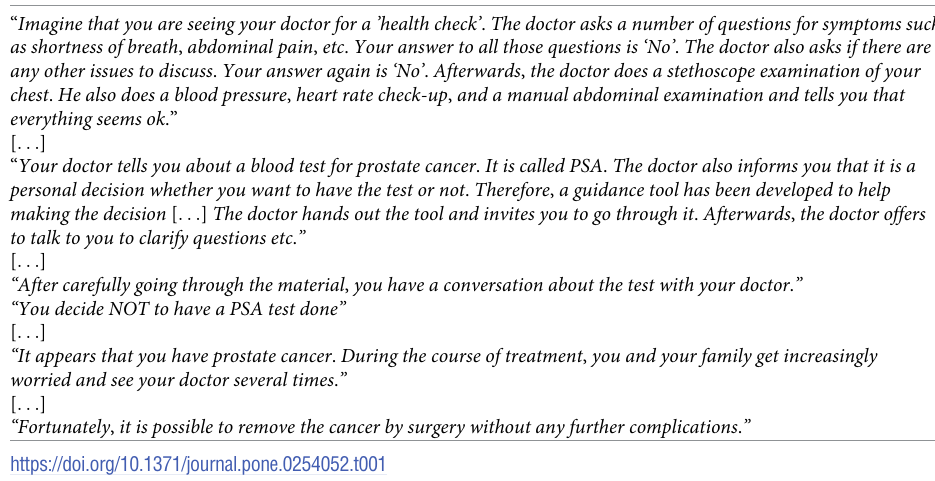
Table 1. Extracts from one case vignette